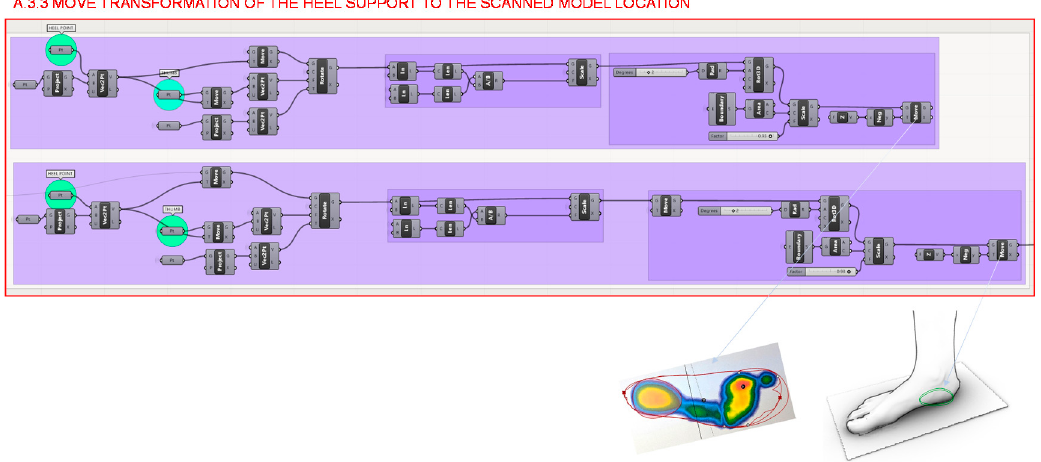
Figure 16. Programming structure definition developed to move the heel support to the location of the scanned model.